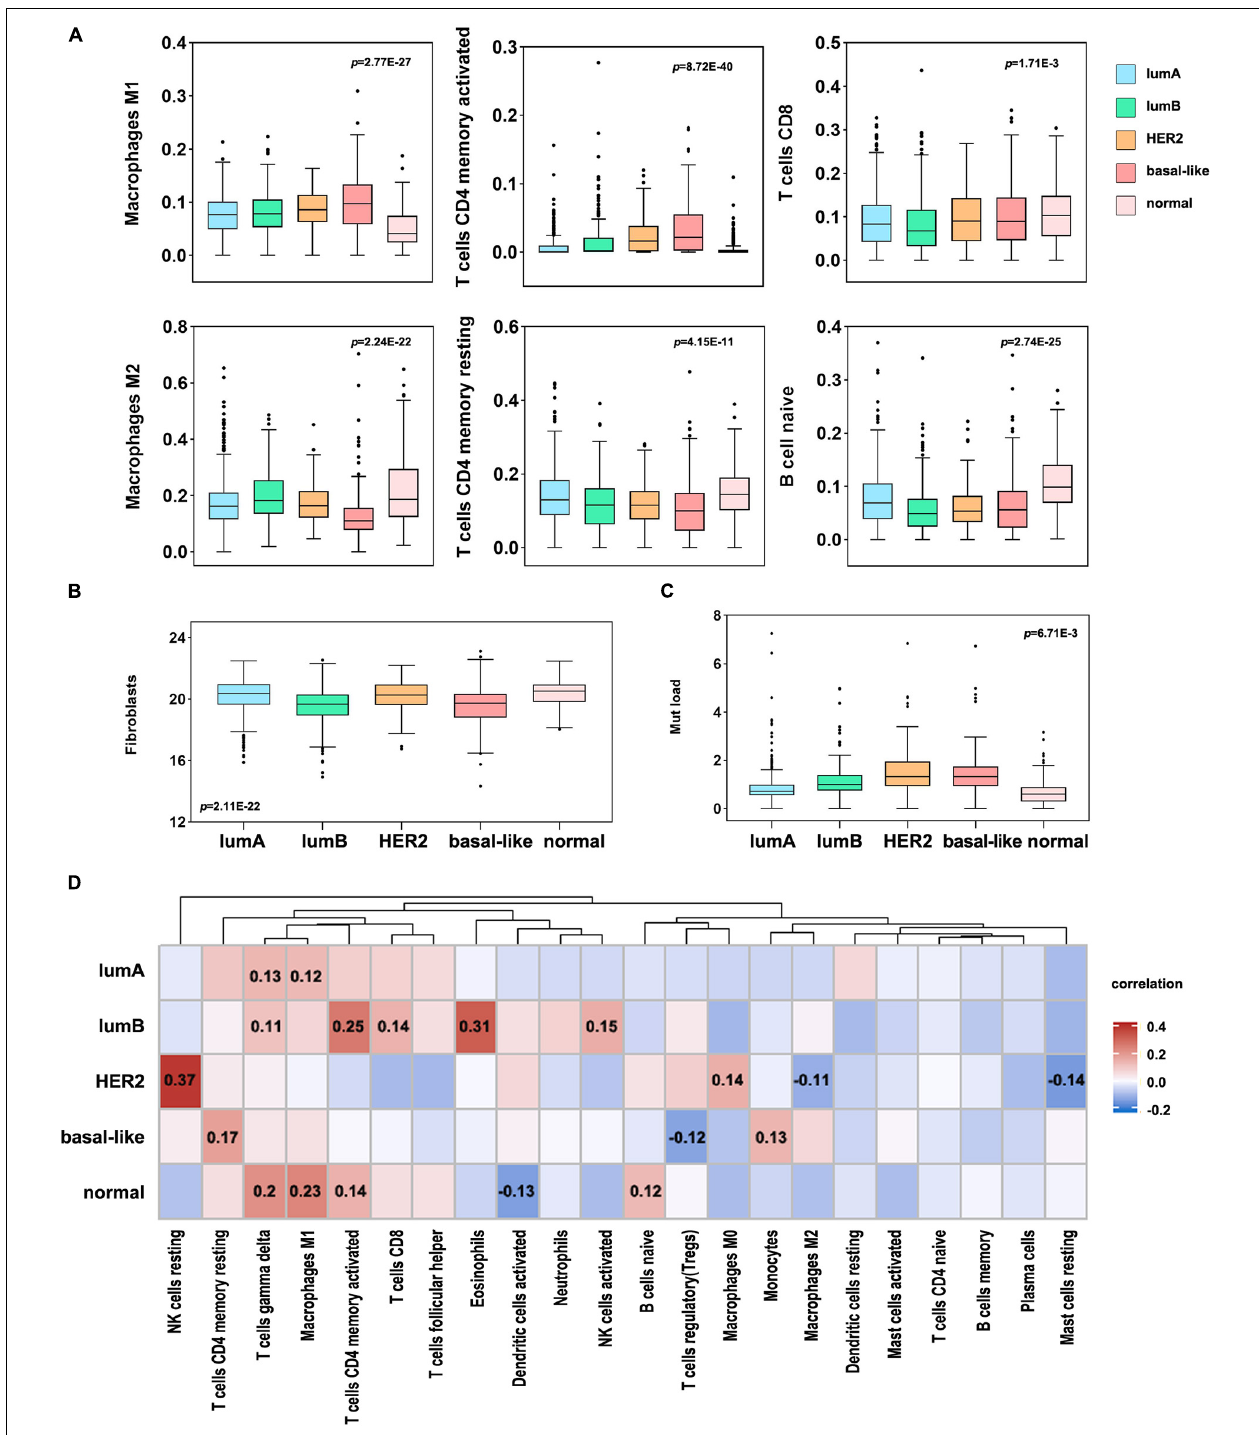
FIGURE 5 | Immune cell infiltration levels in different breast cancer subtypes. (A) Differential analysis of the immune cell infiltration level in different breast cancer subtypes ( p < 0.05). (B) The infiltration level of fibroblasts in different breast cancer subtypes. (C) Analysis of TMB in different breast cancer subtypes. (D) Correlation analysis between TMB and 22 immune cell infiltration levels in different subtypes. Red indicates a positive correlation, and blue indicates a negative correlation. The number represents the degree of correlation, and p < 0.05.